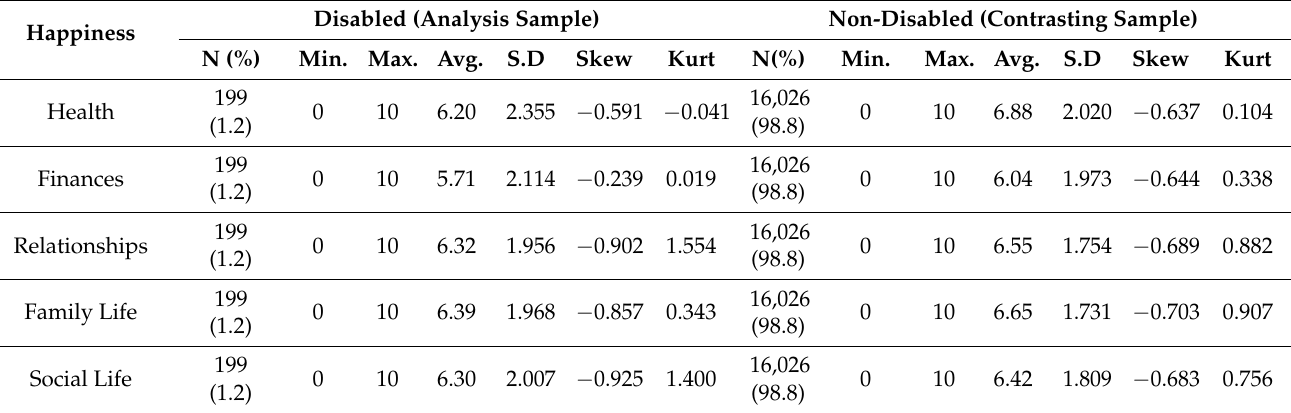
Table 3. Comparative results of happiness levels by disabled and non-disabled individuals.